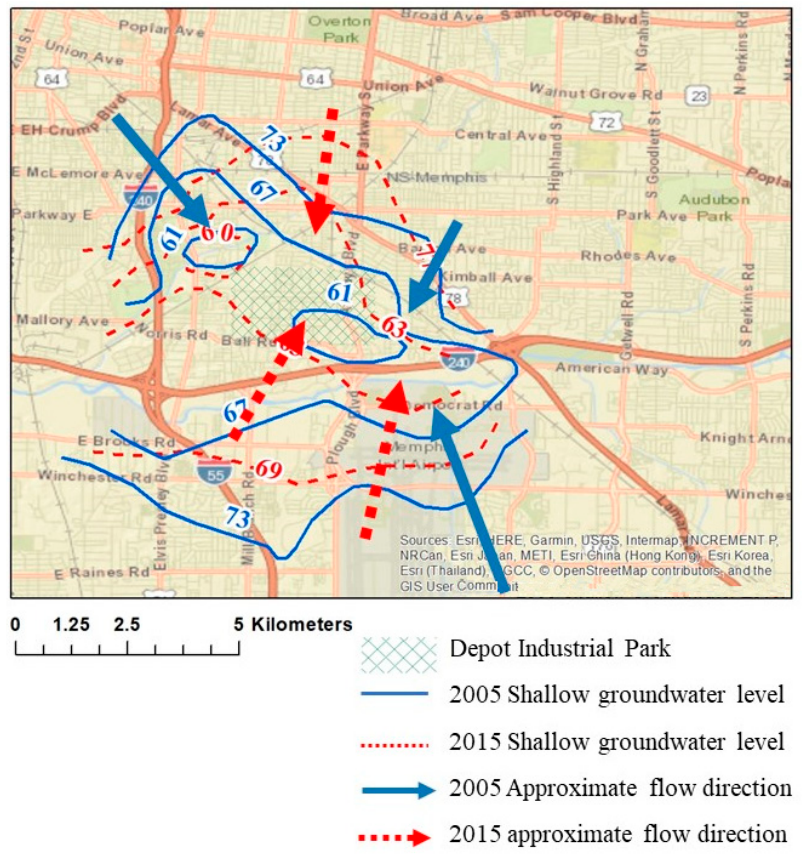
Figure 9. A map of the Shallow aquifer groundwater level, and approximate flow directions in 2005 (blue arrow) and 2015 (red arrow) at the MDIP area.